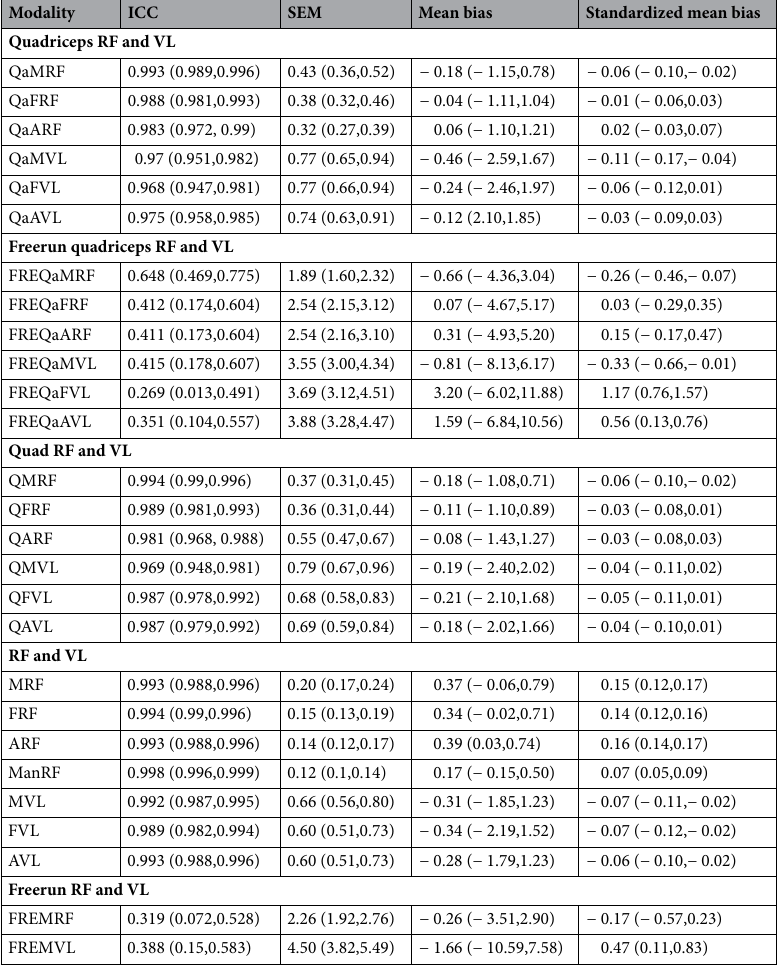
Table 1. Intra-class correlation (ICC), standard error of measurement (SEM) and standardized mean bias with 95% compatibility interval. Mean bias with limits of agreement set to ± 1.96 standard deviations (SD). Values for SEM and mean bias are displayed in cm 2 with standardized mean bias being displayed in SDs. All values calculated for m. rectus femoris (RF) and m. vastus lateralis (VL) comparing ACSAuto to manual measurements. “Quadriceps” (Qa), “Quad” (Q) and separate image modes were used. “Manual” (M), “Fixed pixels” (F) and “Automatic” (A) outline-finder starting points. Freerun (fre) and manual scaling (ManRF) trials were compared as